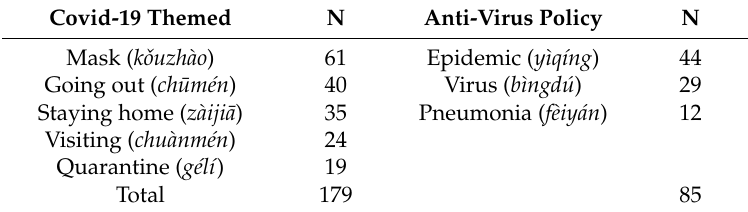
Table 2. Frequency of COVID-19 related words; 2020 banner survey; 17 January to 23 February.